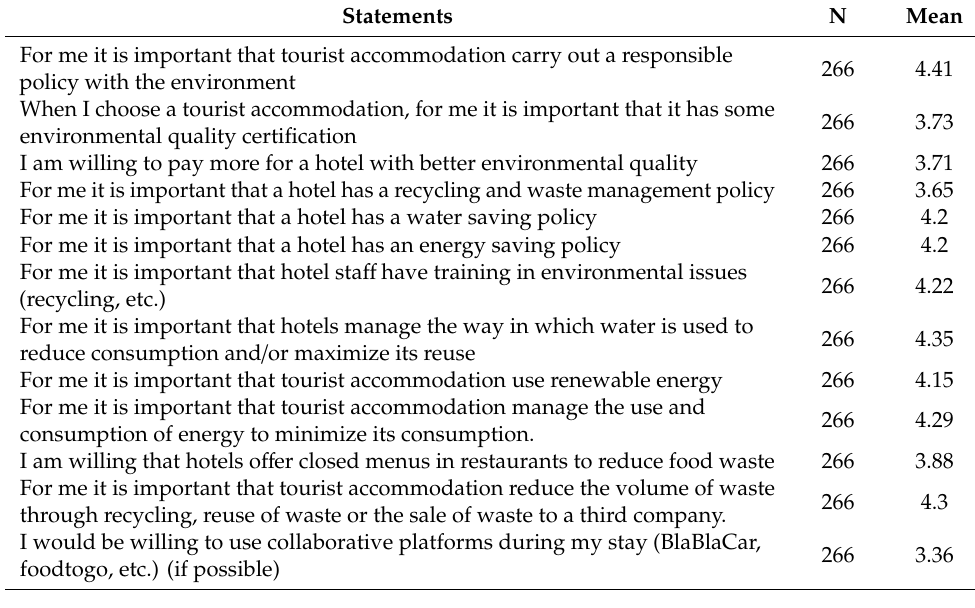
Table 4. Statements related to circular economy (CE) in hotel